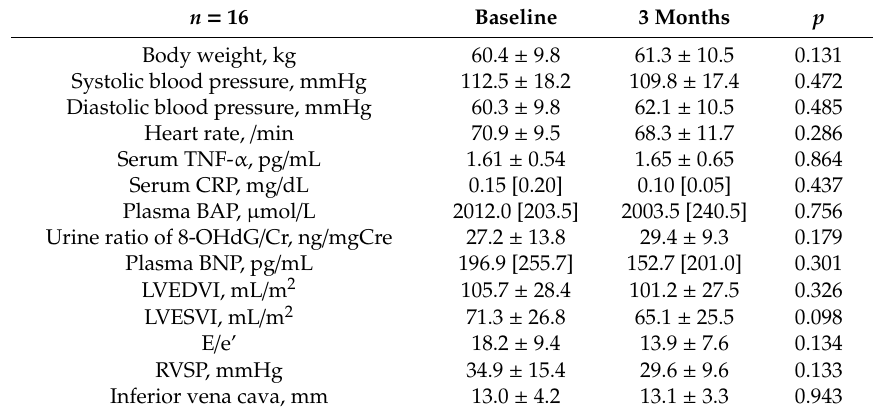
Table 2. Changes in parameters from baseline to 3 months other than dROM, LVEF, and 6MWD. n =